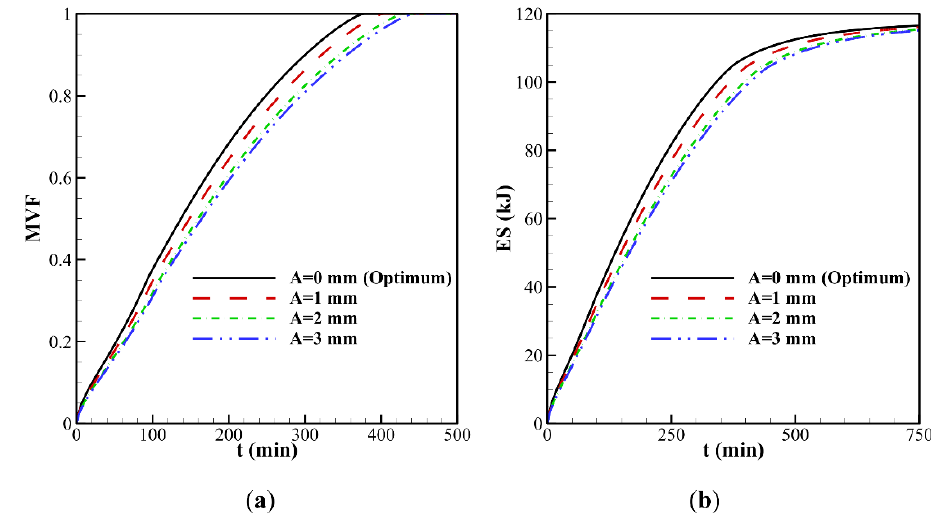
Figure 10. Effect of wave amplitude ( A ) for ω na = 0.06 and N = 4: ( a ) melting volume fraction; ( b ) total energy storage. The last control factor to be assessed is the number of undulations N of the wavy